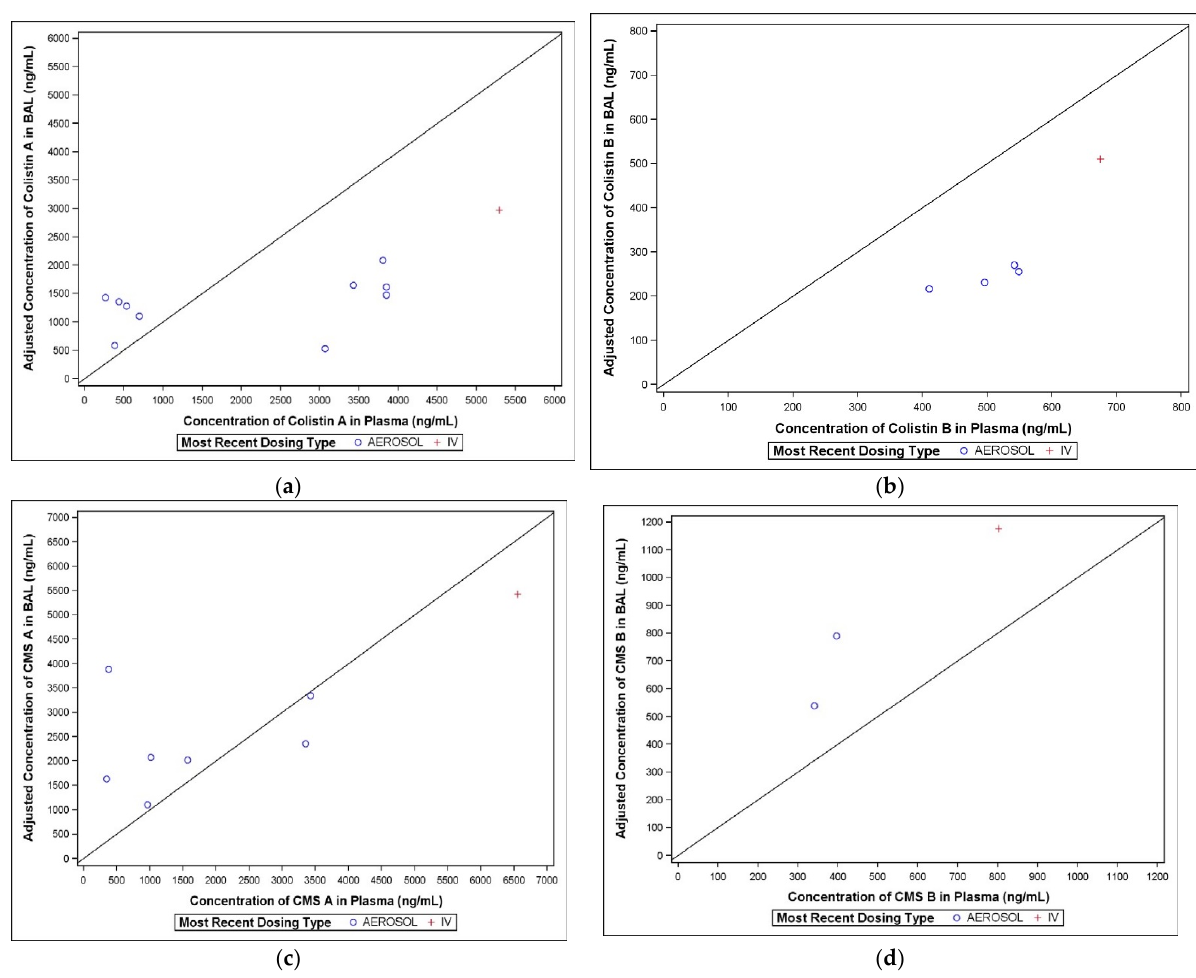
Figure 5. ( a – d ) Comparison of colistin A concentrations in BAL and plasma.